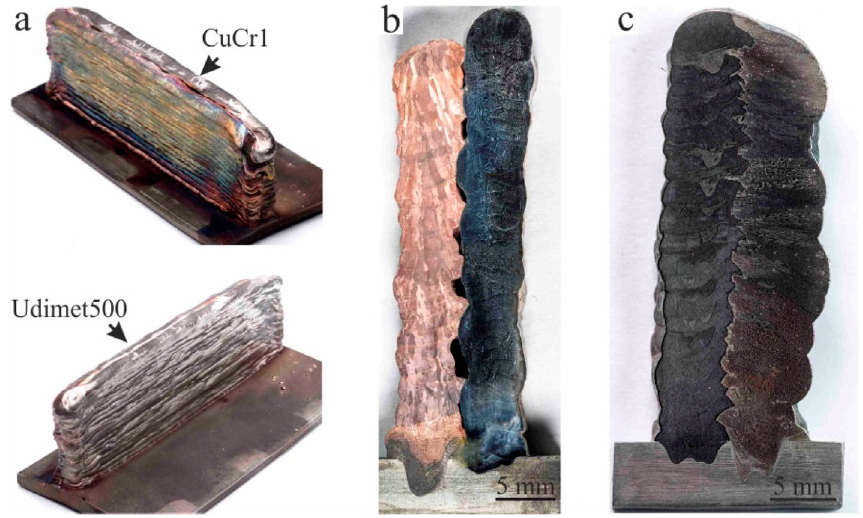
Figure 16. ( a ) Appearance and ( b ) macrostructure of samples obtained by alternating printing of two separate “walls” and ( c ) by alternating printing with changing through each layer of printed material